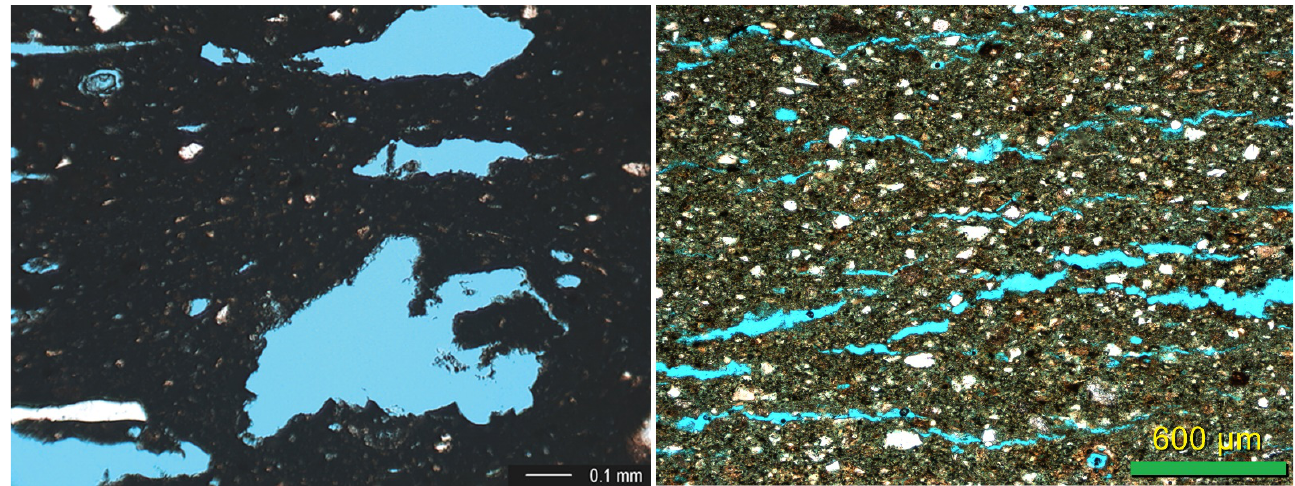
Figure 18. Processing and fabrication effects include inhomogeneous distribution of pore sizes and shapes ( left ) from incomplete kneading of the clay; and elongated parallel-aligned pores ( right ) from fabrication methods involving application of pressure. Both views are in transmitted plane polarized light, with pores blue.